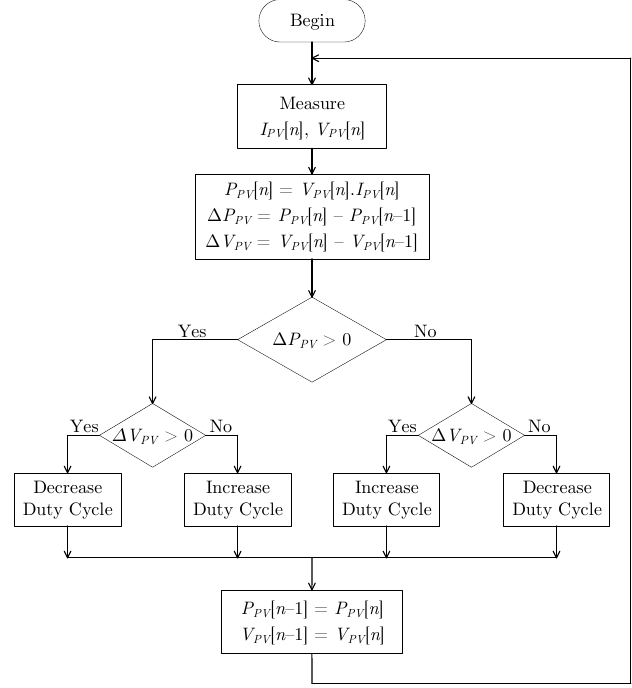
Figure 4. Perturb and observe algorithm’s